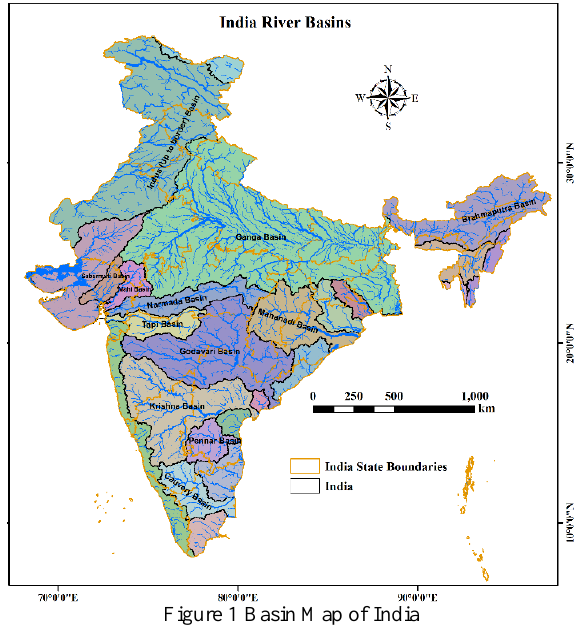
Figure 1 Basin Map of